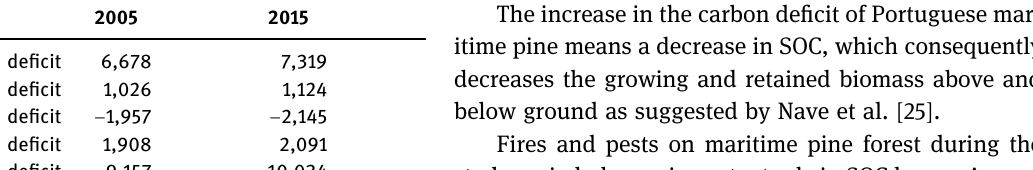
Table 4: Land use impact for the FU ( 1 m 3 of maritime pine, standing, in forest ) Substance Unit